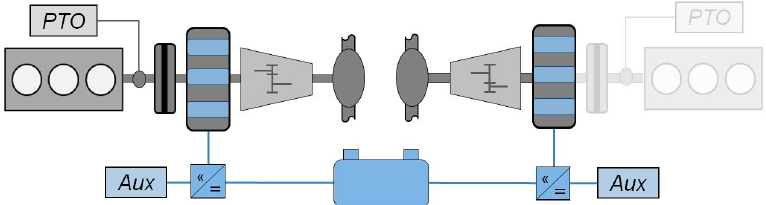
Figure 3. Scheme of a parallel hybrid propulsion system for a diesel multiple unit train